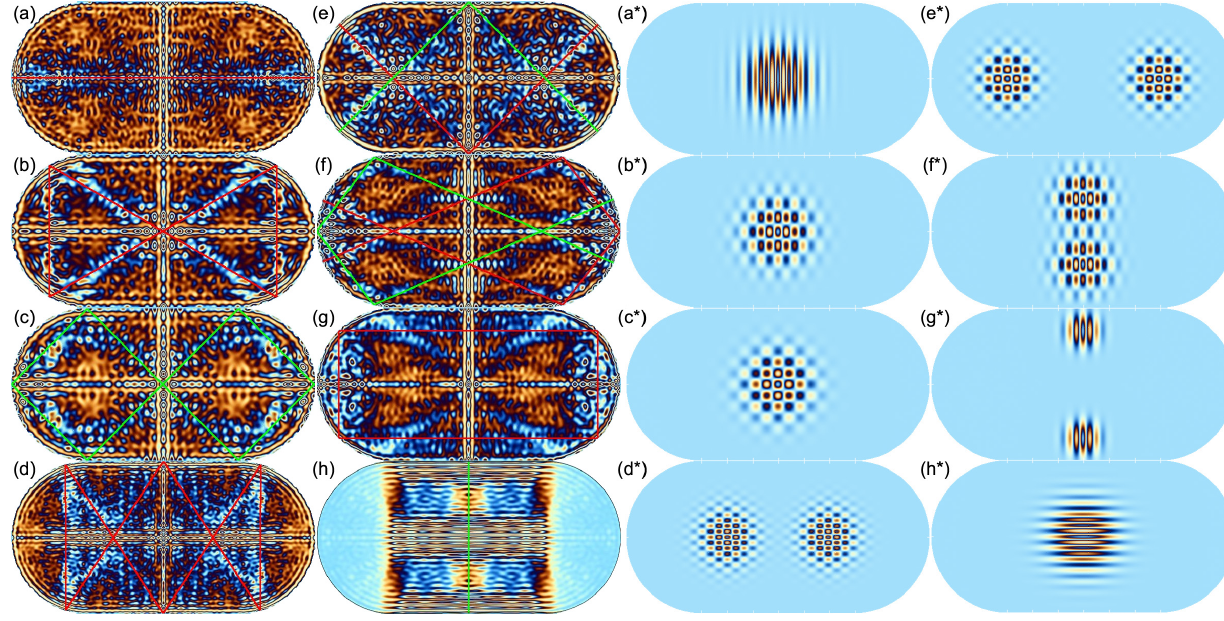
Figure 2: Evidence of scarring: Superposition of the first 3300 iterations of a wave function initiated by two di ff erent generating functions (a and c in Figure 3) with wavelength chosen to be a fraction of the associated classical repelling orbit. Panels (a) and (b) show superposition of phase amplitudes, whereas (c) and (d) the corresponding superimposed probability distributions of the squared amplitudes, showing evident scarring. Generally the probability distributions give better resolution of the scarring. (e) The wave function cellular automaton iterates in two stages. First in the transition 1 → 2 white positions move using black neighbour values. Then in the transition 2 → 3 black positions move. Finally in the transition 3 → 4 white positions move again. This enables a discrete simulation of a Hamiltonian process. Supplement 1: Quicktime movie of the wave function cellular automaton operating.